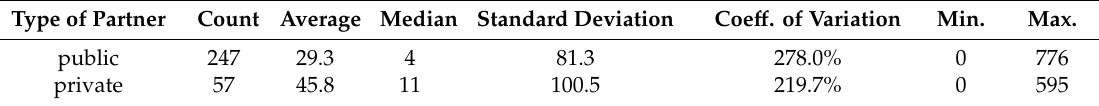
Table 6. Basic descriptive statistics for the number of partnerships, depending on the type of supporting partner. Type of Partner Count Average Median Standard Deviation Coe ff . of Variation Min. Max. public 247